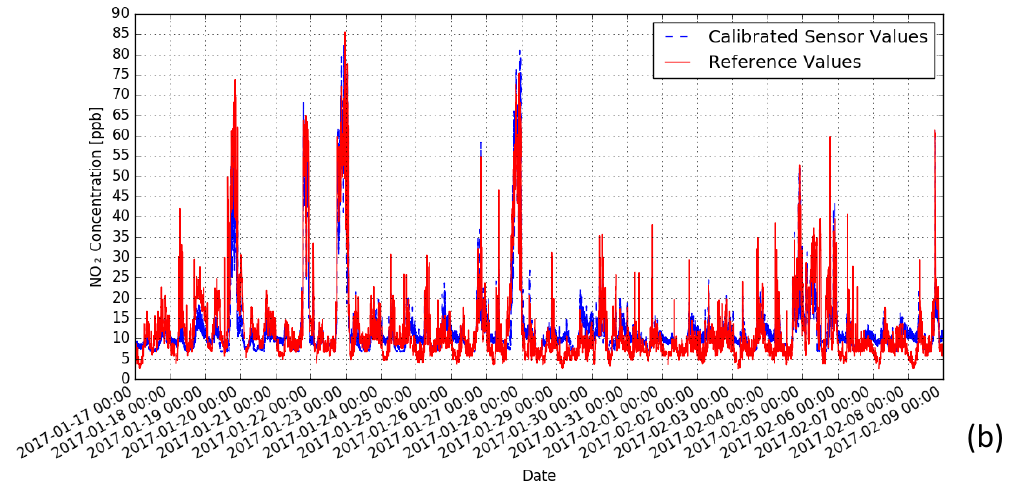
Figure A4. Line plots of calibrated sensor values from CO and NO 2 Sensor-Modules, and reference values from EPD’s station. ( a ) CO data pairs; ( b ) NO 2 data